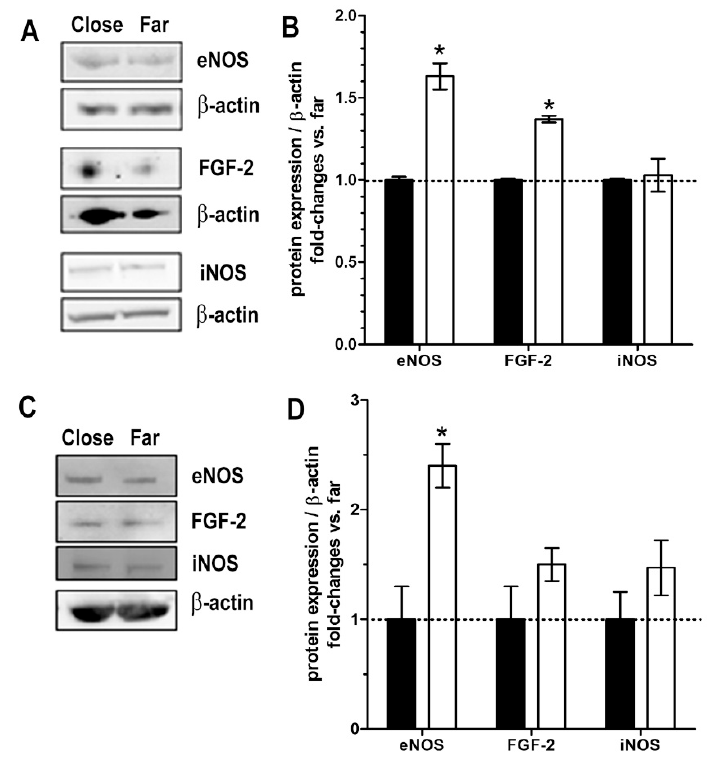
Figure 10. Western blots and densitometric quantitation for the endothelial integrity and functional markers FGF-2, eNOS and the inflammatory and tissue remodeling marker iNOS in the specimens of skin ( A , B ) and saphenous vein ( C , D ) taken in proximity to (close) or distant from (far, 3–5 mm) the surgical wound. β -actin was used as a loading invariant protein and assumed as reference control. ( A , C ) Representative blots of 3 independent experiments; ( B , D ) Bar graphs showing quantitation of the noted markers normalized to β -actin and expressed as fold-changes of the values measured in the samples taken far from the wound. Values are mean ± s.e.m., n = 4; * p < 0.05; no marks, not significant.